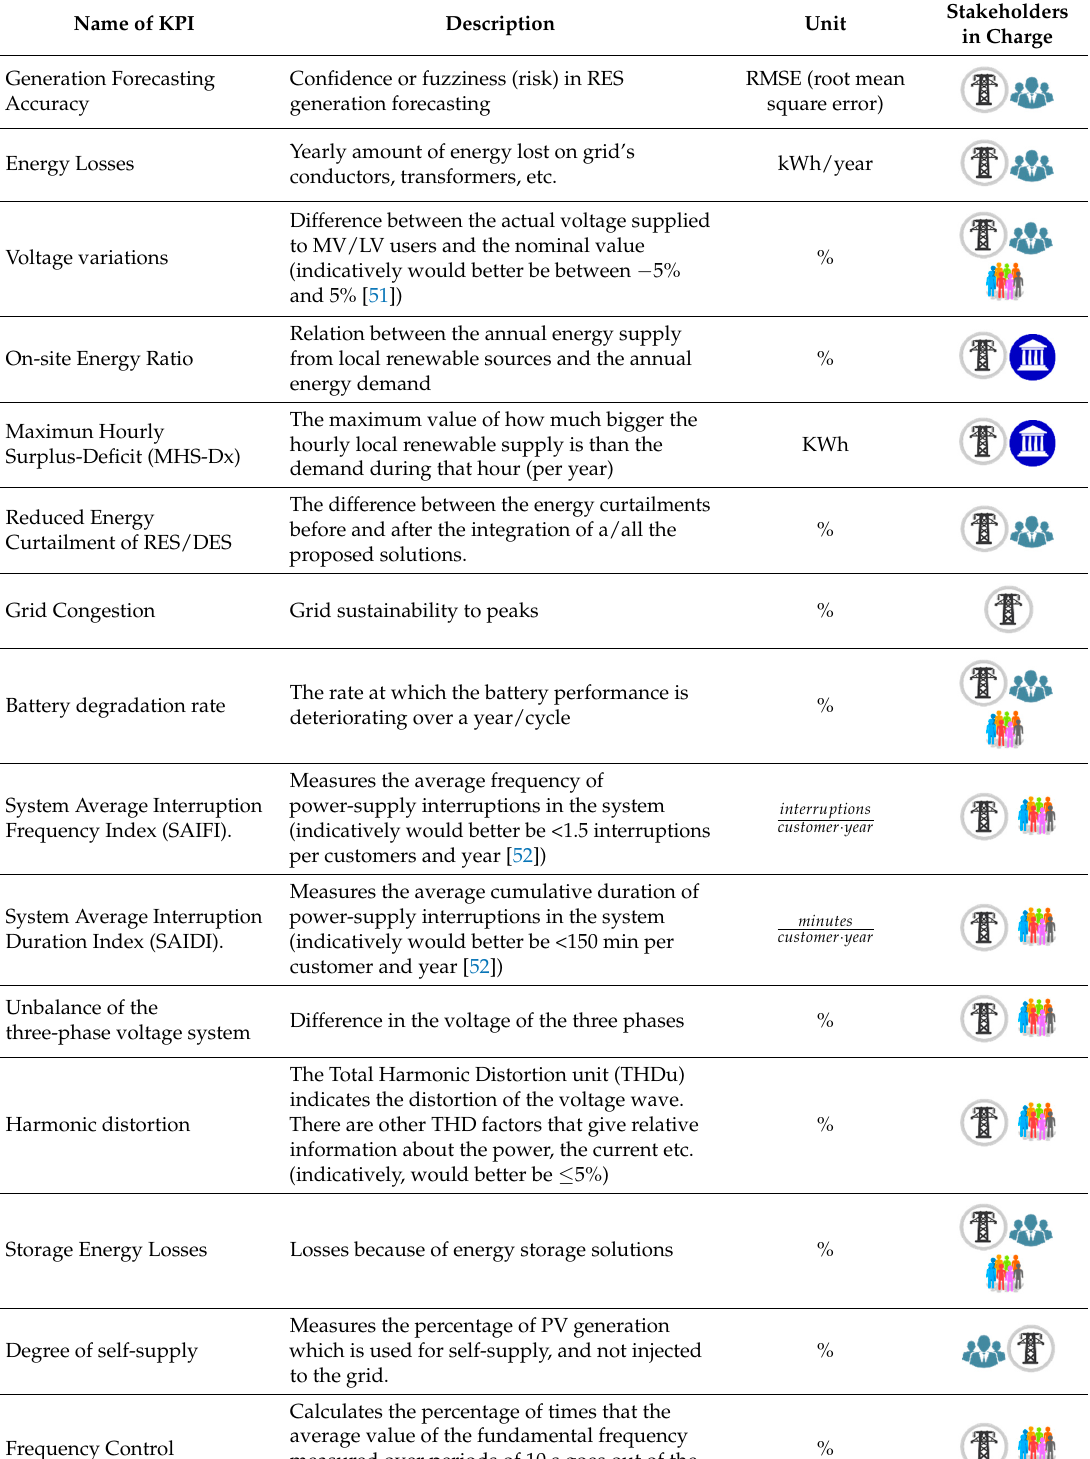
Table 5. List of Environmental KPIs.